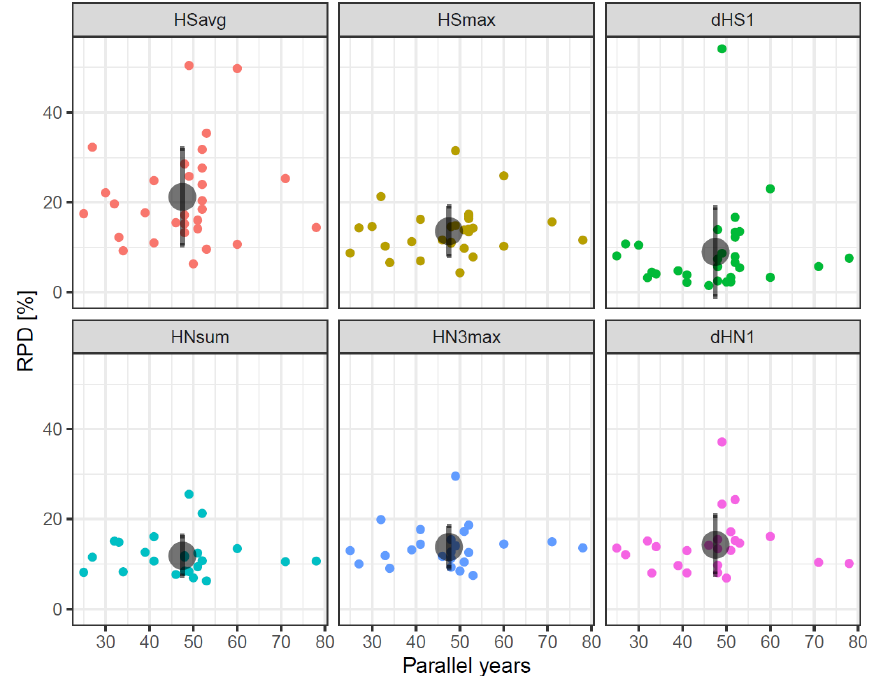
Figure 1. Relative percentage differences (RPDs) as a function of number of parallel years for six snow climate indicators. Black dots and error bars indicate mean and standard deviations. The variables are defined in Table 1. Snow depth (HS) and snowfall (HN) indicators are based on 30 and 24 station pairs,